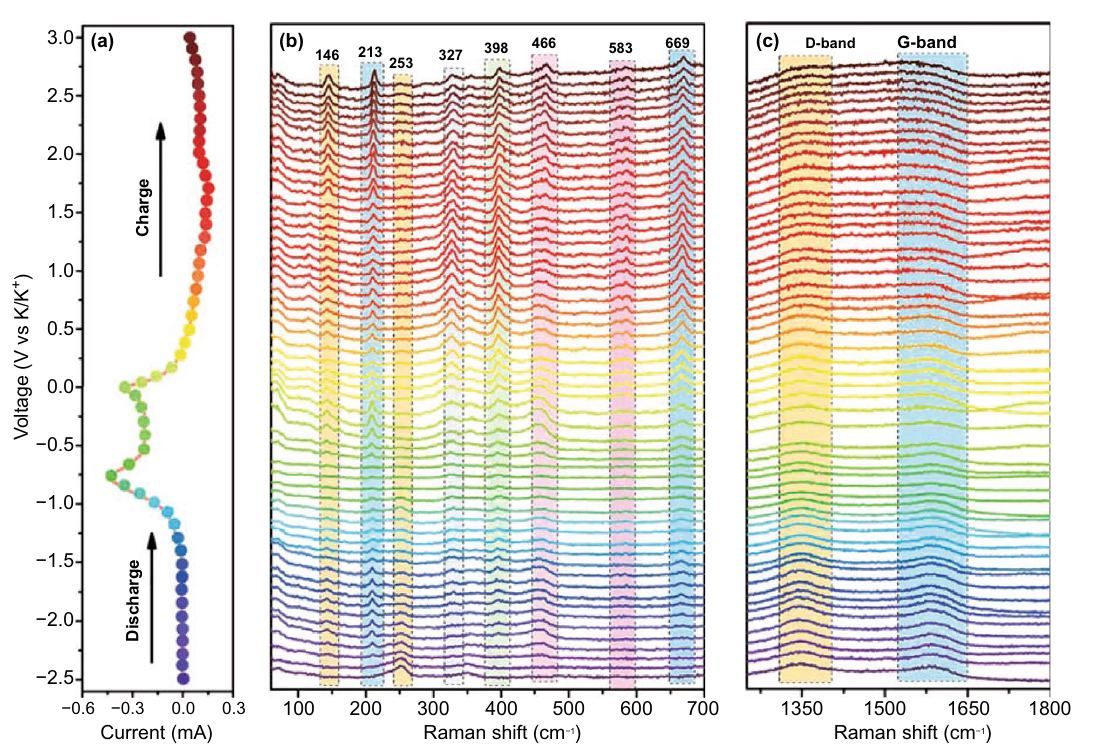
Fig. 7 In situ Raman spectra of FeSe 2 @RGO electrode using DME-based electrolyte in different potassiation–depotassiation states: a the cor- responding voltage position; in situ Raman spectra at b low wavenumbers and c high